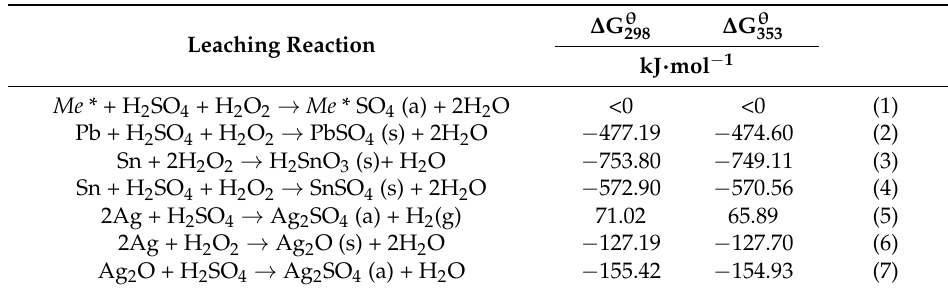
Table 2. Δ G ᶿ for reactions of metals with H 2 SO 4 and H 2 O 2 . Table 2. ∆ G θ for reactions of metals with H 2 SO 4 and H 2 O 2